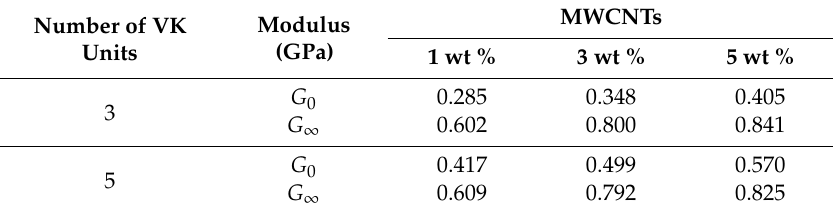
Table 3. Instantaneous shear modulus and shear modulusat infinite for the PP / MWCNT nanocomposite.